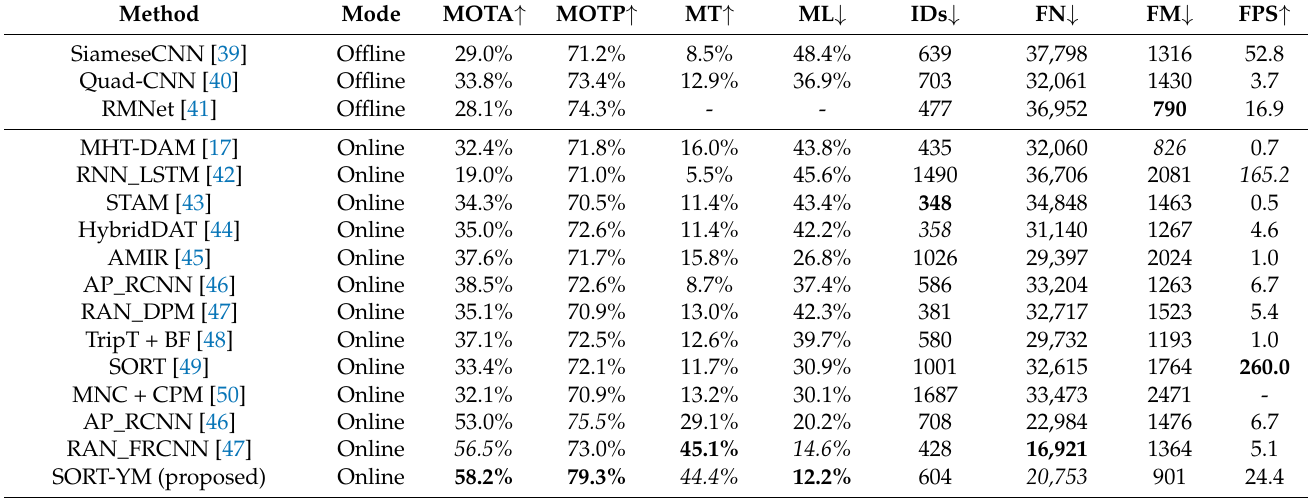
Table 2. The quantitative results by our proposed method and state-of-the-arts on MOT-15 dataset. ↑ denotes that higher is better and ↓ represents the opposite. The best and sub-optimal results are highlighted in bold and